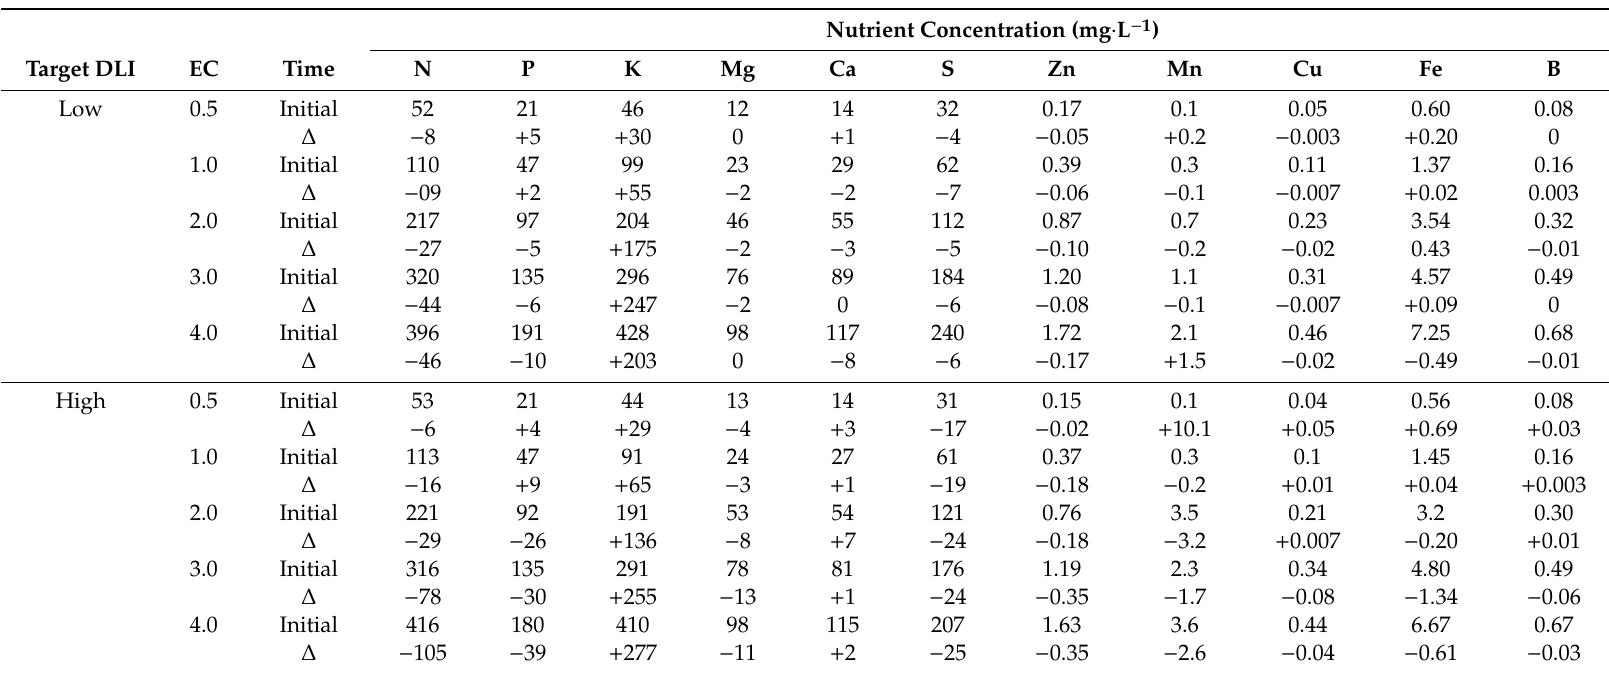
Table 2. Nutrient concentrations of hydroponic nutrient solutions for ( Coriandrum sativum ‘Santo’), dill ( Anethum graveolens ‘Fernleaf’), and parsley ( Petroselinum crispum ‘Giant of Italy’) grown in hydroponic systems under low (~7.0 mol · m − 2 · d − 1 ) or high (~18.0 mol · m − 2 · d − 1 ) daily light integral (DLI) with a range of